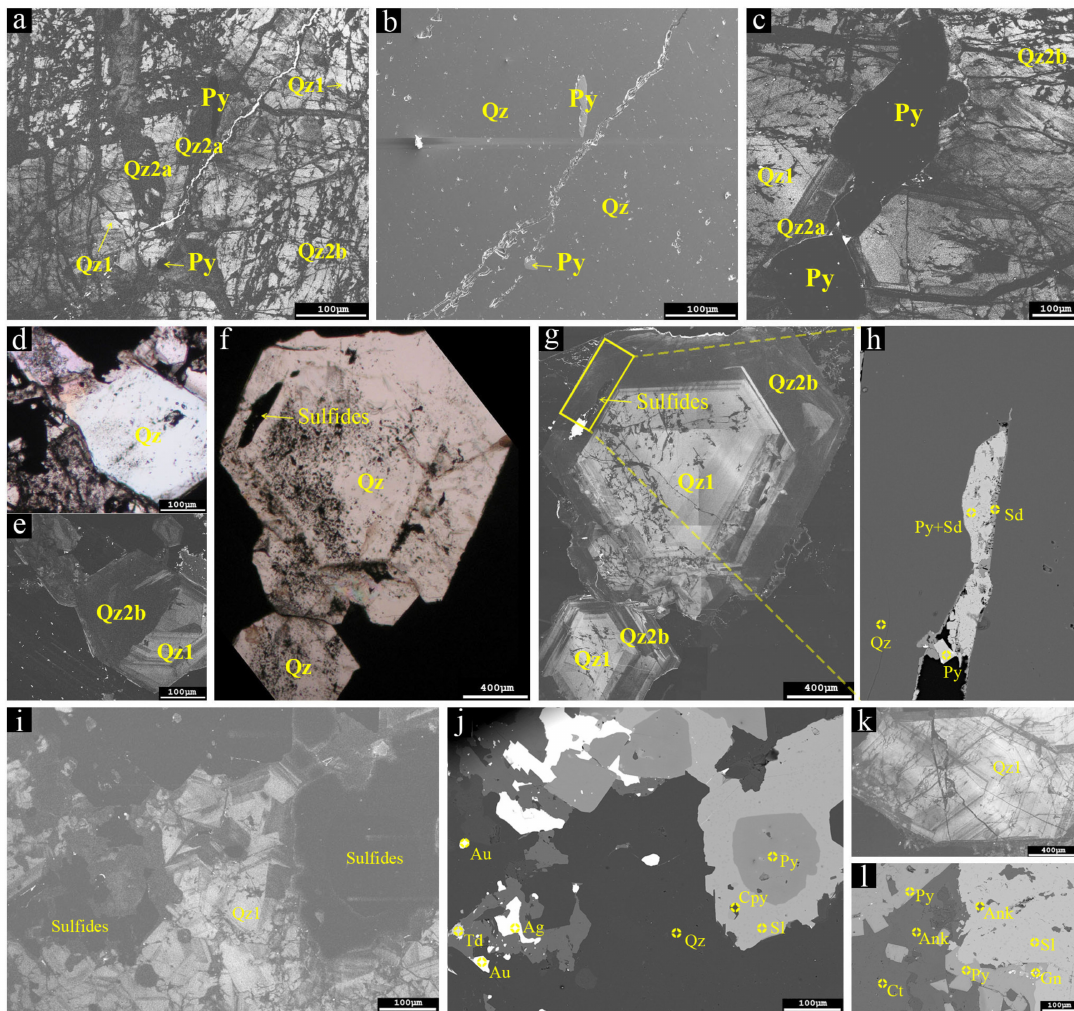
Figure 5. Microscopic and SEM-cathodoluminescence (CL) images of quartz samples of the Linglong goldfield. ( a ) CL-bright Qz1 crosscut by later CL-gray to dark Qz2a in V1 vein; ( b ) secondary electron image of (a); ( c ) Pyrite grain intergrown with Qz2a in a V2 vein; ( d ) Euhedral quartz under transmitted light in a V2 vein; ( e ) Qz1 recrystallized by Qz2b with the same view as (d); ( f ) Euhedral quartz under transmitted light in V3 vein; ( g ) Qz1 recrystallized by Qz2b with the same view as image (f); ( h ) Backscattered electron (BSE) image with energy dispersive spectrometry (EDS) analyses of the area enlarged from (f); ( i ) Qz2b intergrown with sulfides in a V3 vein, with abundant relict Qz1; ( j ) EDS analysis of the same area of (i); ( k ) Qz1 in aV4 vein; ( l ) EDS analysis of minerals in a V4 vein. Quartz generations are detailed in the text. Py: pyrite, Sd: siderite, Cpy: chalcopyrite, Gn: galena, Sl: sphalerite, Td: tetrahedrite, Ag: Argentum, Au: Aurum; Ct: calcite; Ank: